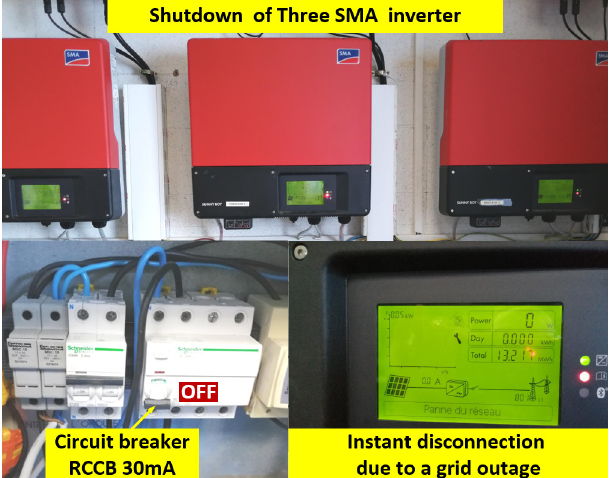
Figure 23. Photos of the occurred open circuit fault after the circuit breaker tripping or after inverter temporary disconnection.